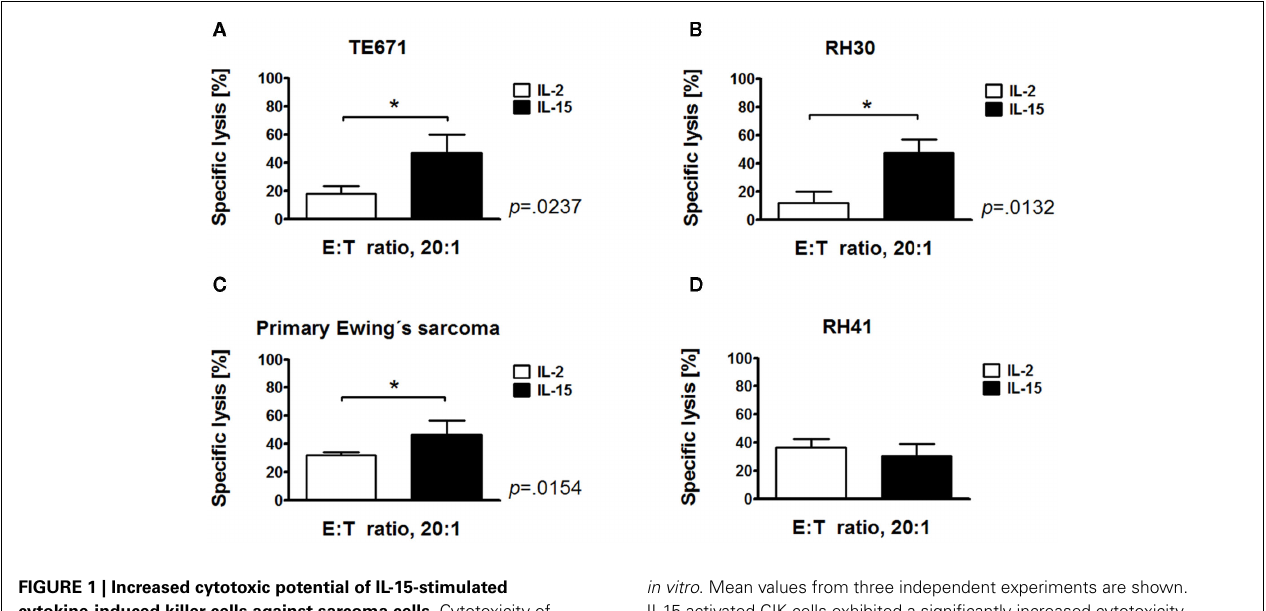
FIGURE 1 | Increased cytotoxic potential of IL-15-stimulated cytokine-induced killer cells against sarcoma cells. Cytotoxicity of IL-15-stimulated and conventional IL-2-stimulated CIK cells after 10days of culture against embryonal rhabdomyosarcoma (RMS) cell lineTE671 (A) , alveolar RMS cell lines RH30 (B) and RH41 (D) , and primary Ewing’s sarcoma cells (C) was analyzed by europium release assay